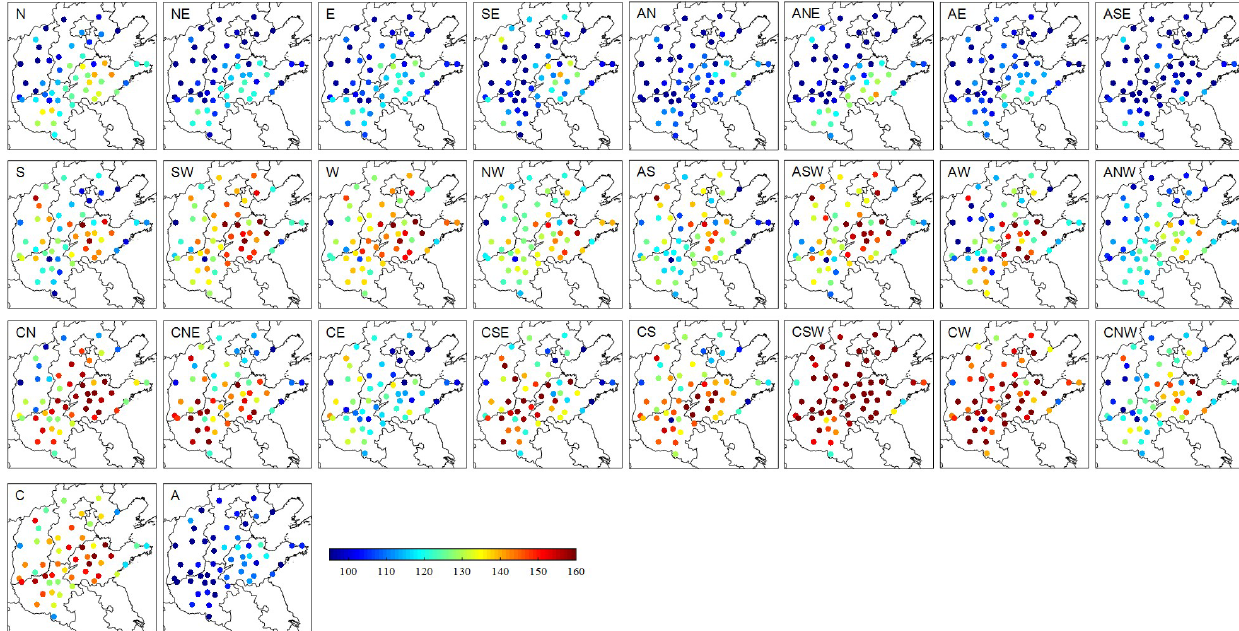
Figure 6. Spatial distribution of average MDA8 O 3 for the 26 weather types. The first, second and third rows correspond to the weather categories N–E–S direction, S–W–N direction and LP, respectively, and the fourth row includes both categories C and A.